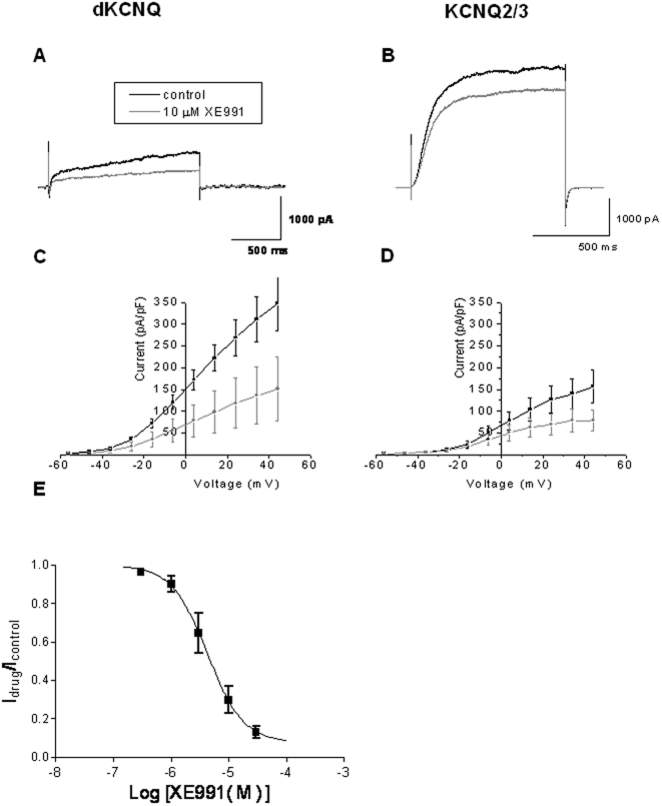
XE991 show conserved inhibition of Drosophila and mammalian KCNQ2/3 channels.Representative traces showing dKCNQ (A) current (black) was sensitive to block by 10 µM XE991 (grey), this is also reflected in the downward shift of the I-V curve (C). Traces (B) and I-V curves (D) showing KCNQ2/3 was sensitive to block by 10 µM XE991. The block was reversible. (E) Dose response curve for XE991 effect on dKCNQ current. dKCNQ n = 6 and KCNQ2/KCNQ3 n = 6.